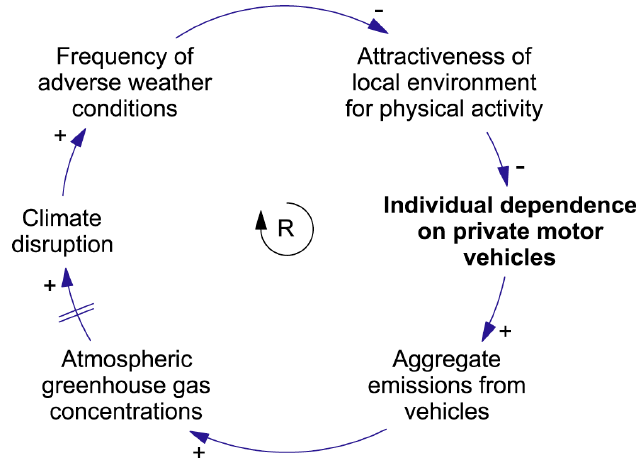
Figure 8. A dynamic hypothesis concerning the interaction between car dependence and climate change. The short parallel lines crossing the link from Atmospheric greenhouse gas concentrations to Climate disruption indicate a delayed